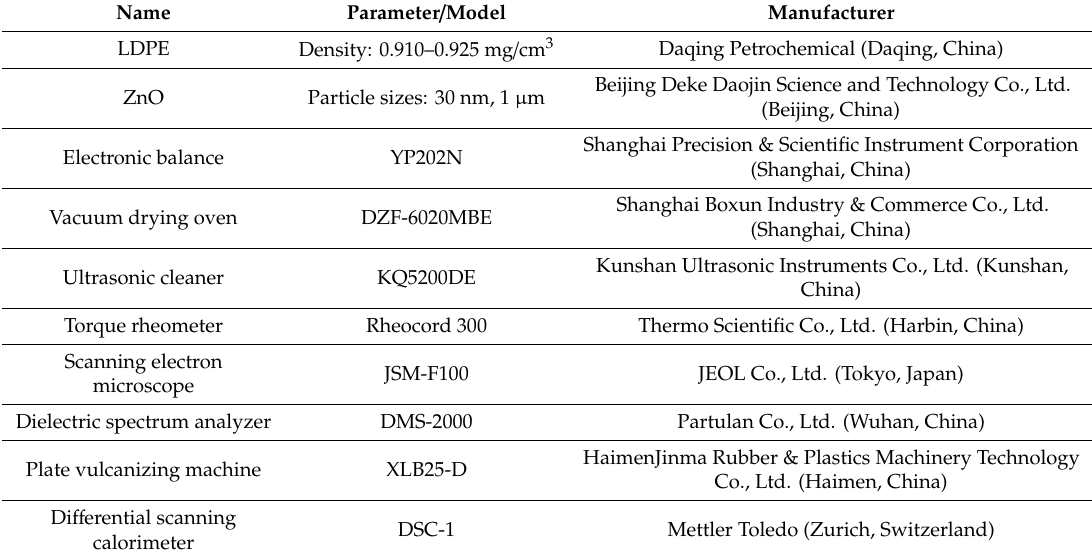
Table 1. Experimental materials and